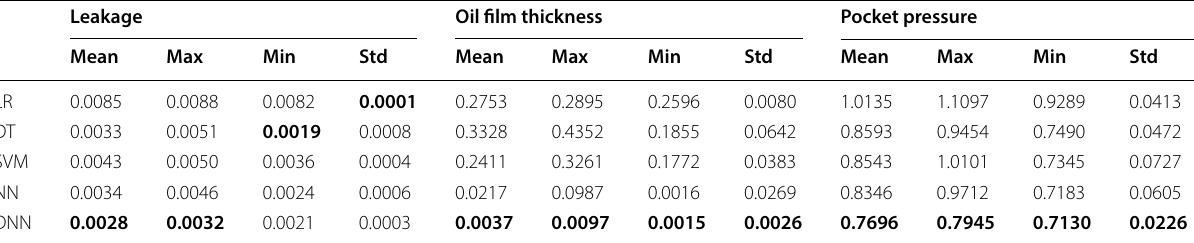
Table 4 Some descriptive statistics for RMSE values